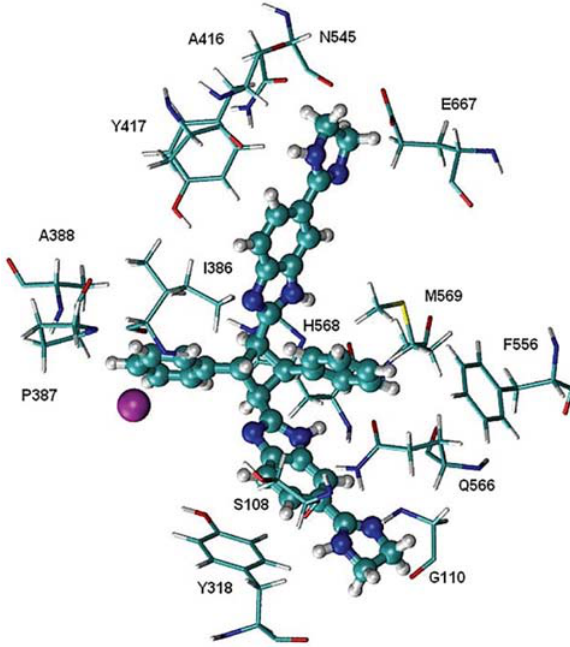
Fig. 7. Orientation and interactions of inhibitor 1 in complex with human DPP III obtained after 40.8 ns of MD simulations. The zinc cation is shown as a magenta sphere, the inhibitor in ball-and-stick, and the amino acid residues in stick